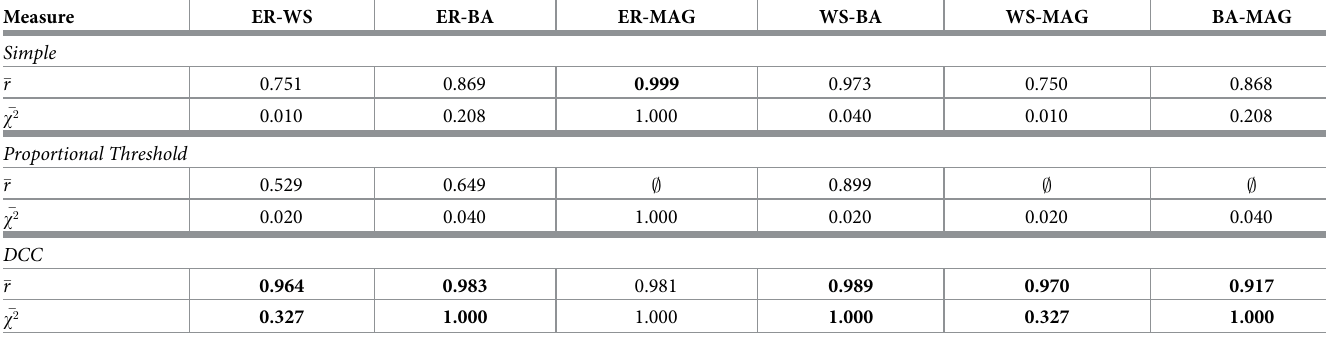
Table 2. Correlation test results measuring similarity between cascades on graph type pairs, by cascade method.